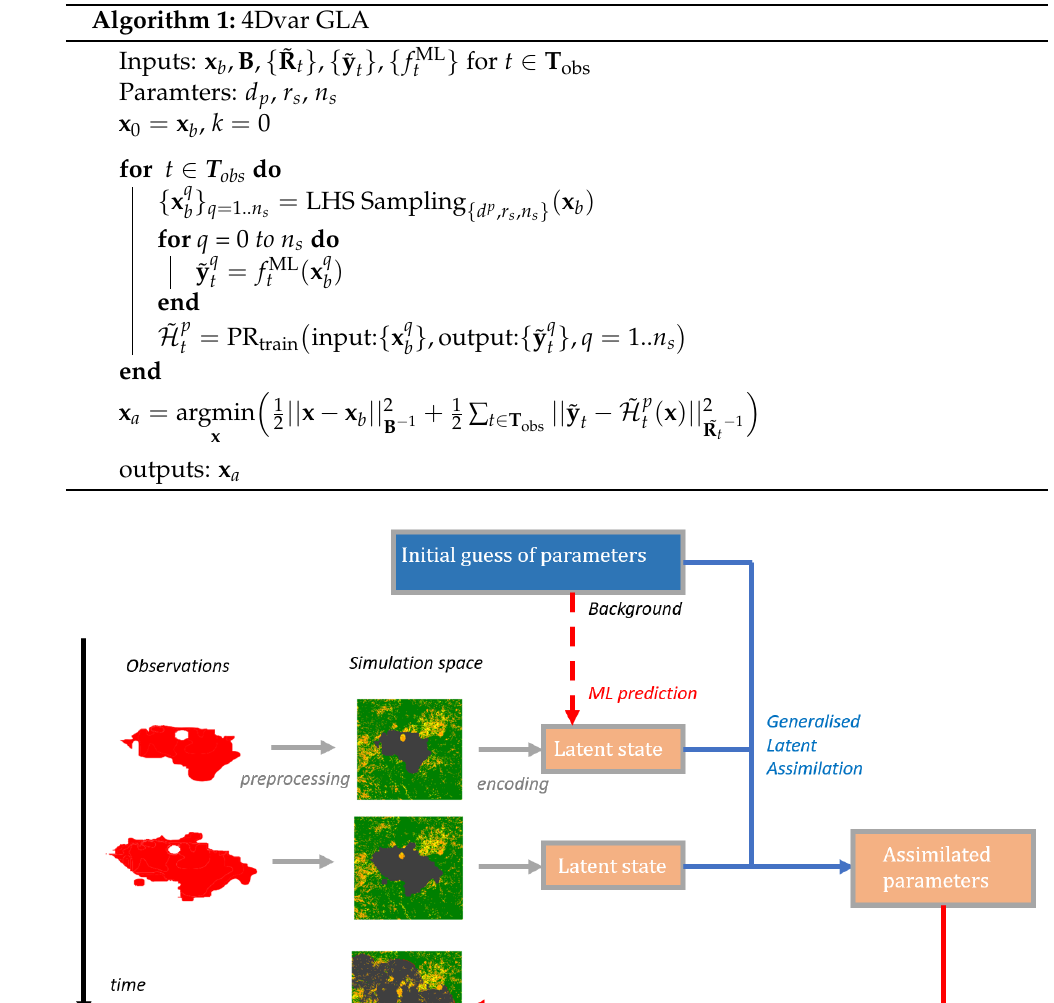
Algorithm 1: 4Dvar GLA